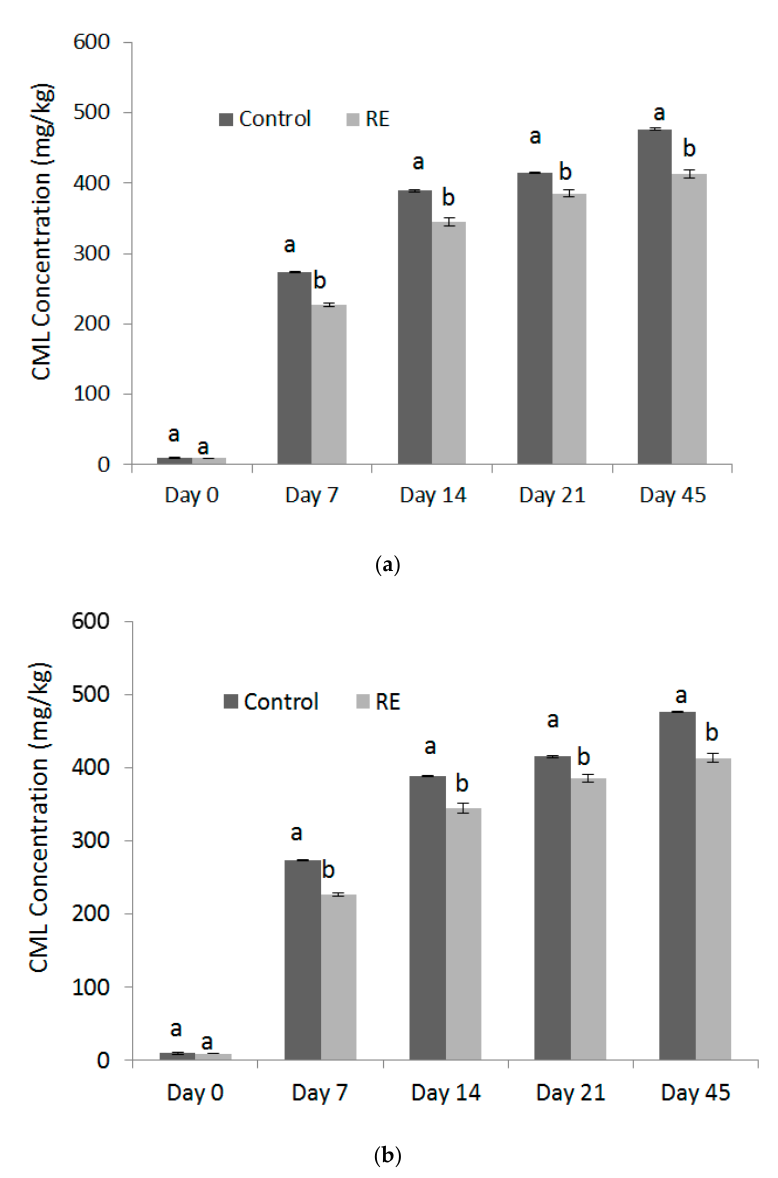
Figure 3. Concentrations of CML formed in control and RE treatment during storage under wa ( a ) 0.75 and ( b ) 0.56 conditions.